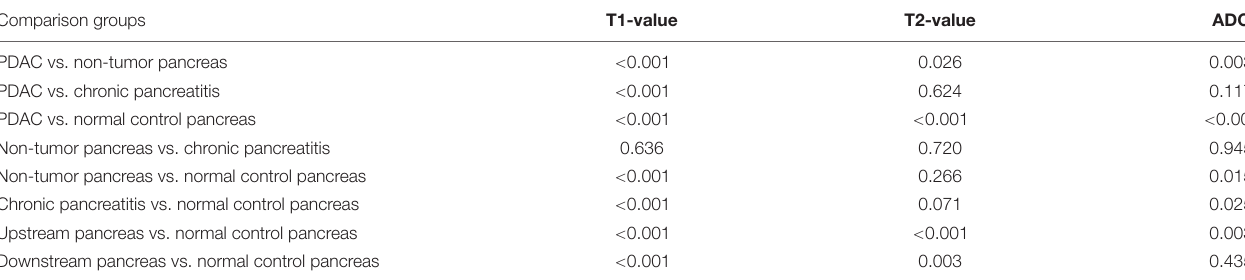
TABLE 5 | p -Values of one-way analysis of variance (ANOVA) in multiple comparisons of PDAC, non-tumor pancreas, CP, and normal control pancreas. Comparison